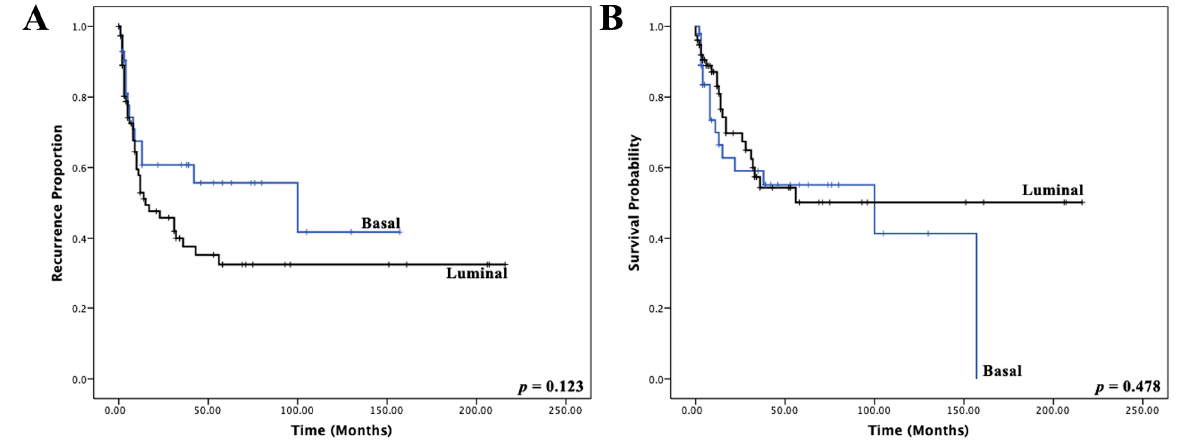
Figure 5. ( A ) Kaplan–Meier plots and log-rank p -values correlating the two NanoString-based gene expression molecular subtypes with recurrence-free survival ( B ) and disease-specific survival.